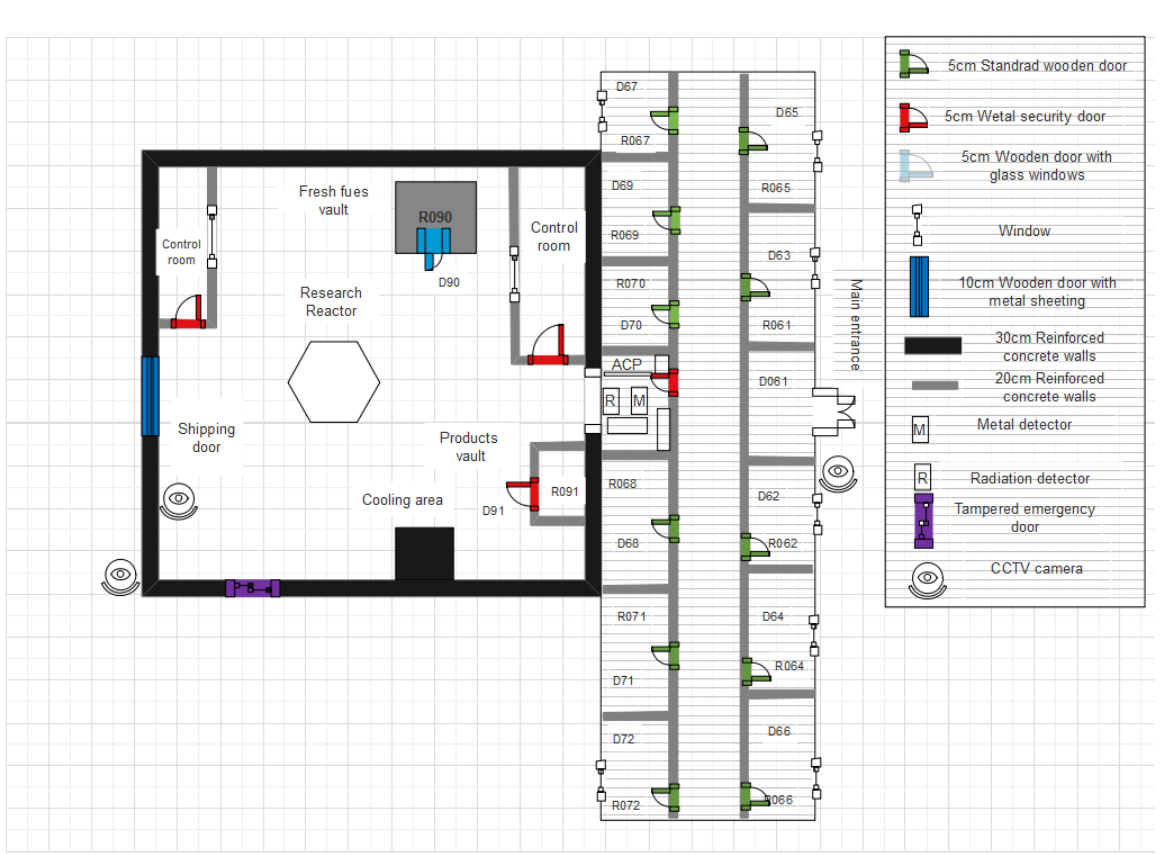
Figure 4: The New Research Reactor Building Floor